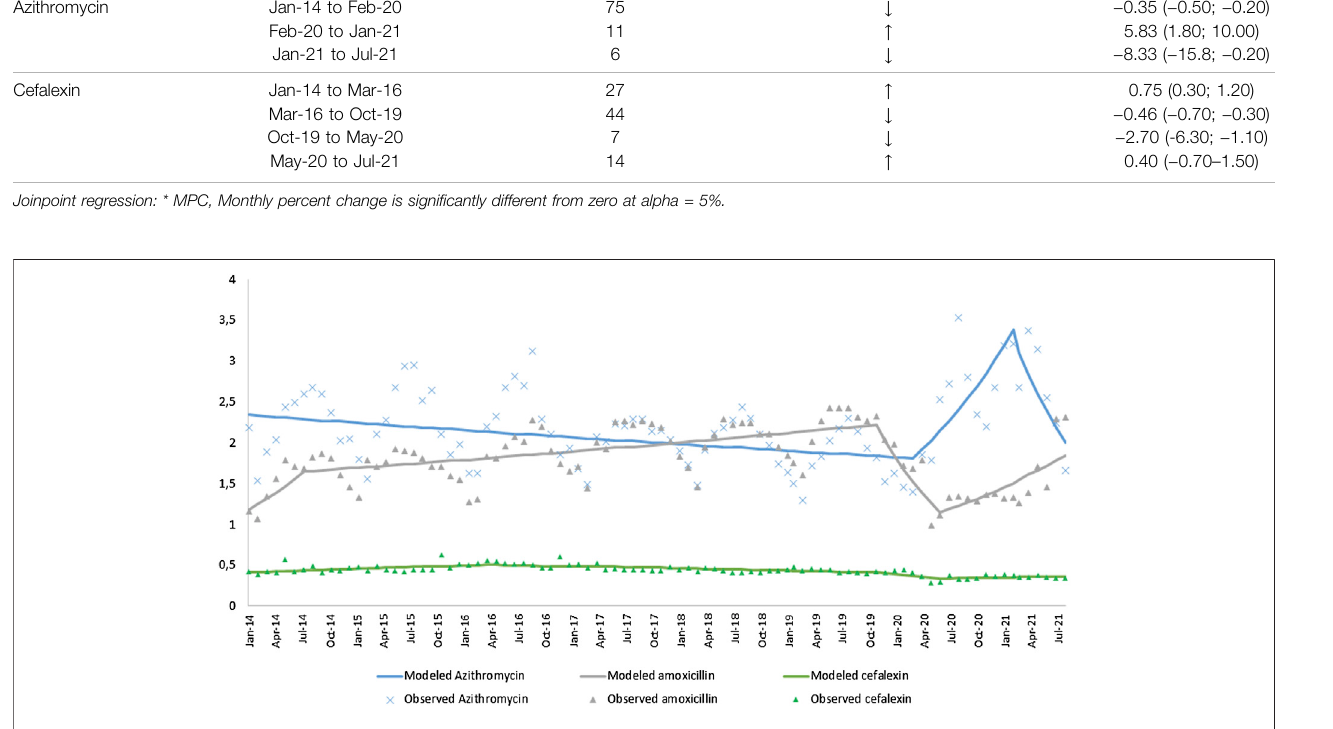
Frontiers in Pharmacology |